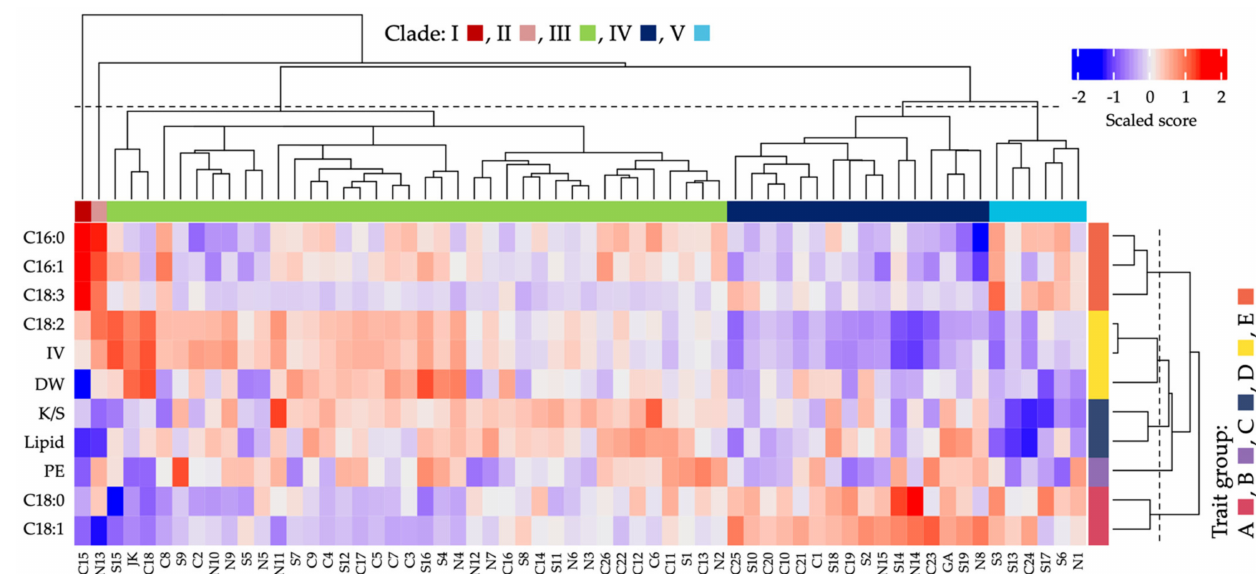
Figure 5. A clustered heat map of seed chemical components among Botswanan accessions. Left vertical and bottom horizontal axes show chemical traits and accession IDs, respectively. The plotted colors represent metabolite levels and are based on the log 2 -transformed ratio of the measured metabolite concentration to the mean concentration of the metabolite across all accessions, as shown in the legend at the top right corner. Data for each metabolite is mean-centered, such that the average log 2 across all samples is set as zero. The dendrograms for the accessions and chemical traits are shown at the top horizontal and right vertical axes, respectively. Half the height of the dendrogram was used as the threshold level for both clade and trait categorization, shown by the broken lines. The categorized accession clades and chemical trait groups are indicated using color codes along the